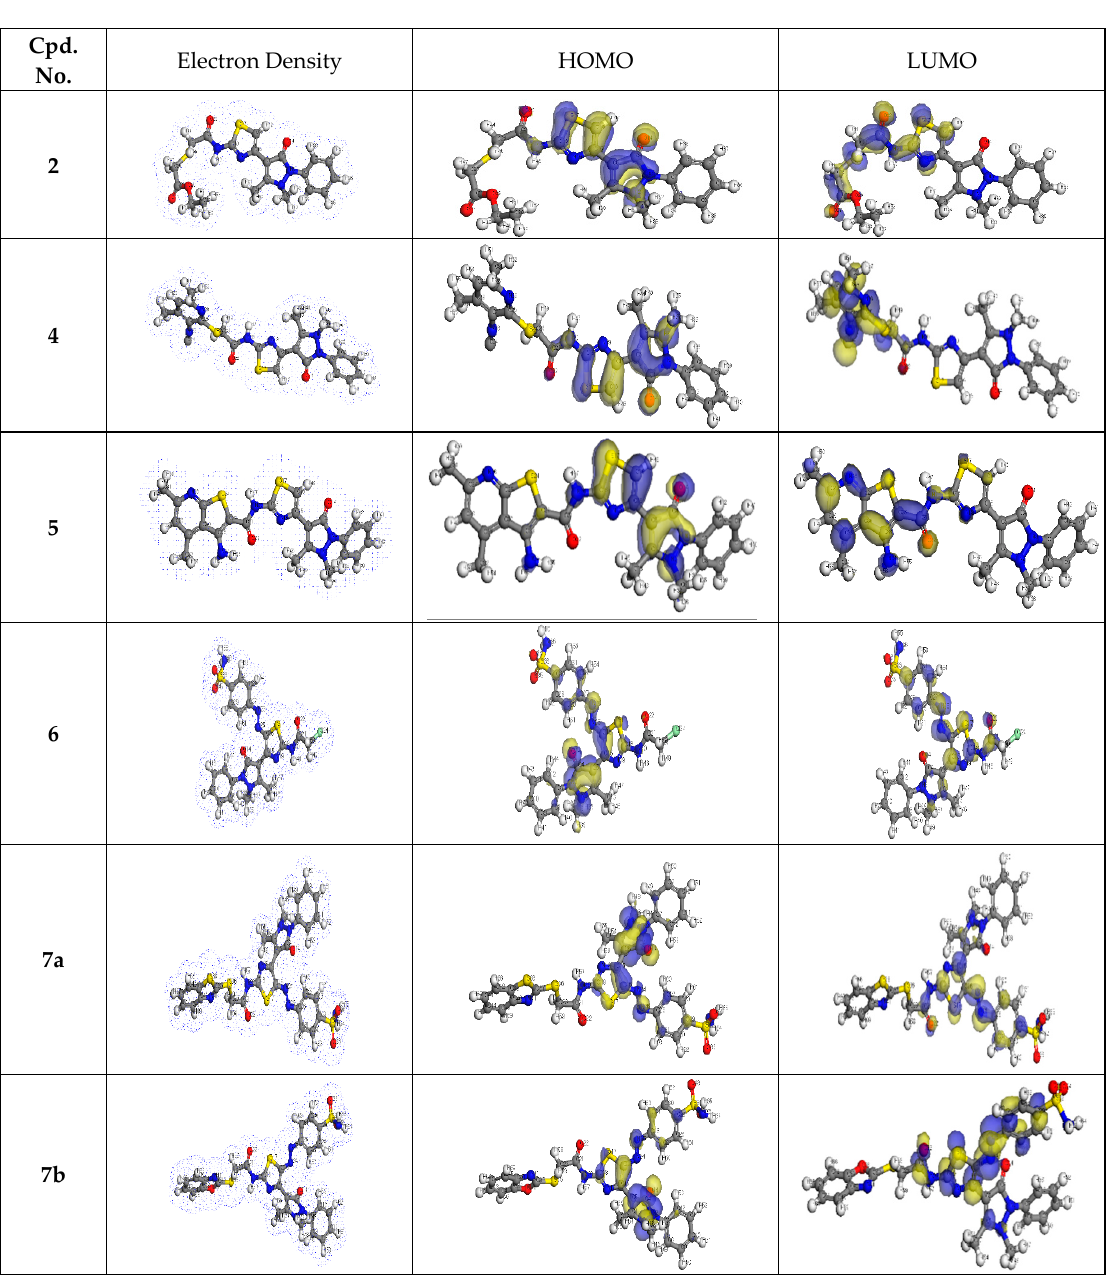
Figure 1. The electron density, the highest occupied molecular orbital (HOMO) and lowest unoccupied molecular orbital (LUMO) frontier orbitals of 4-antipyrinylthiazole derivatives 2 , 4 , 5 , 6 , and 7 .